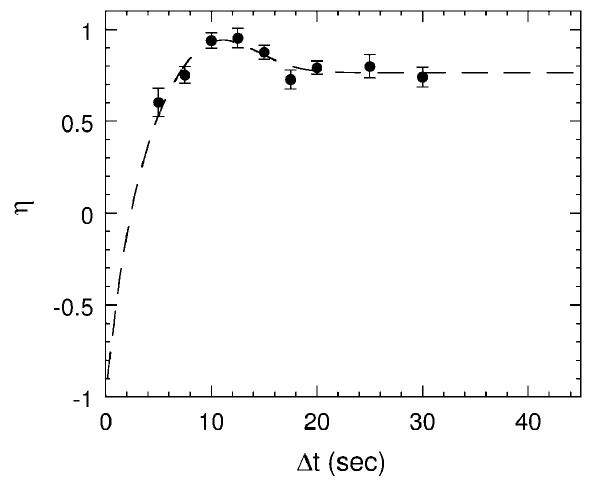
FIG. 5. The efficiency of spin flipping the electron beam at 669.2 MeV is plotted against the rf dipole’s ramp time D t . Its R B dl was 0.07 T mm frequency range D f was 6 1 kHz, and its rms. The dashed line is a hand-drawn curve to guide the